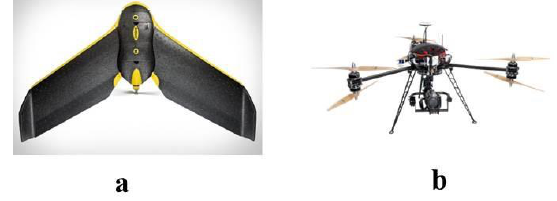
Figure 1: UAVs utilized in the study: (a) Ebee, (b) HDS3.